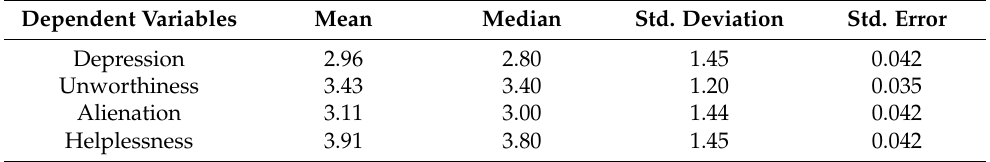
Table 1. Descriptive statistics of the dependent